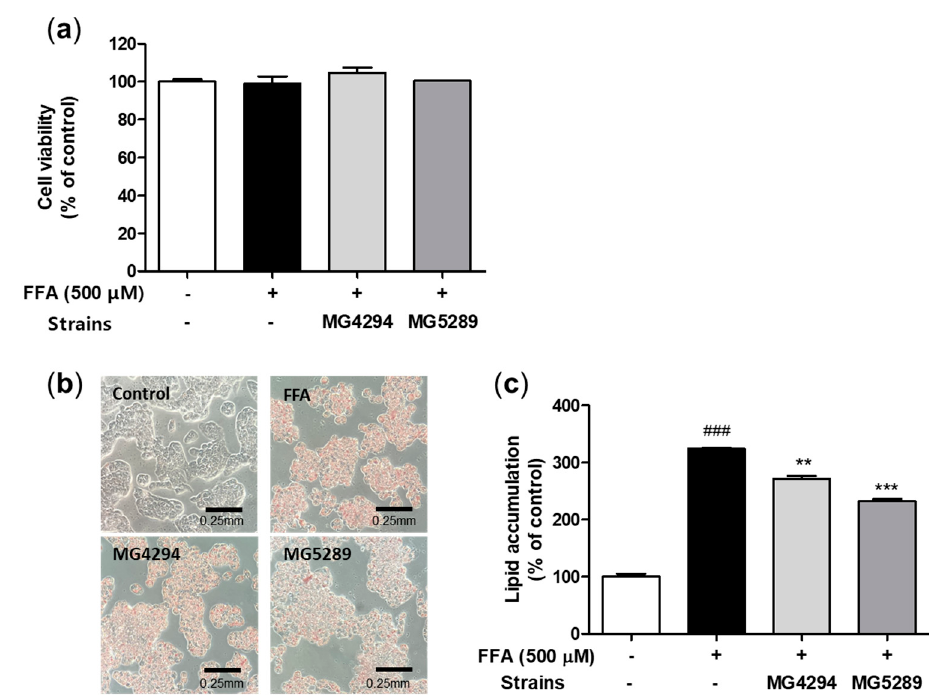
Figure 2. Cell viability and lipid accumulation of L. fermentum MG4294 and L. plantarum MG5289 in FFA-induced HepG2 cells. The cell viability ( a ), representative images of Oil Red O stain ( b ), and lipid accumulation ( c ) on FFA-induced HepG2 cells treated with MG4294 and MG5289. The data are expressed as mean ± SEM ( n = 3). ### p < 0.001 compared with control; ** p < 0.01 and *** p < 0.001 compared with FFA-induced control.